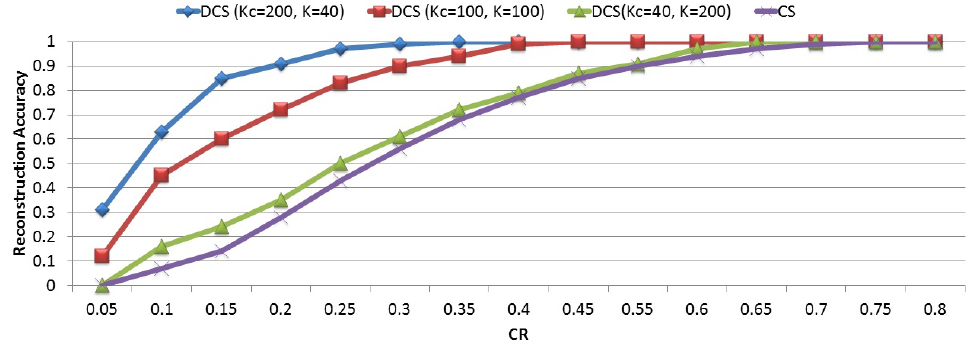
Figure 12. Reconstruction accuracy in terms of different common sparsity levels.